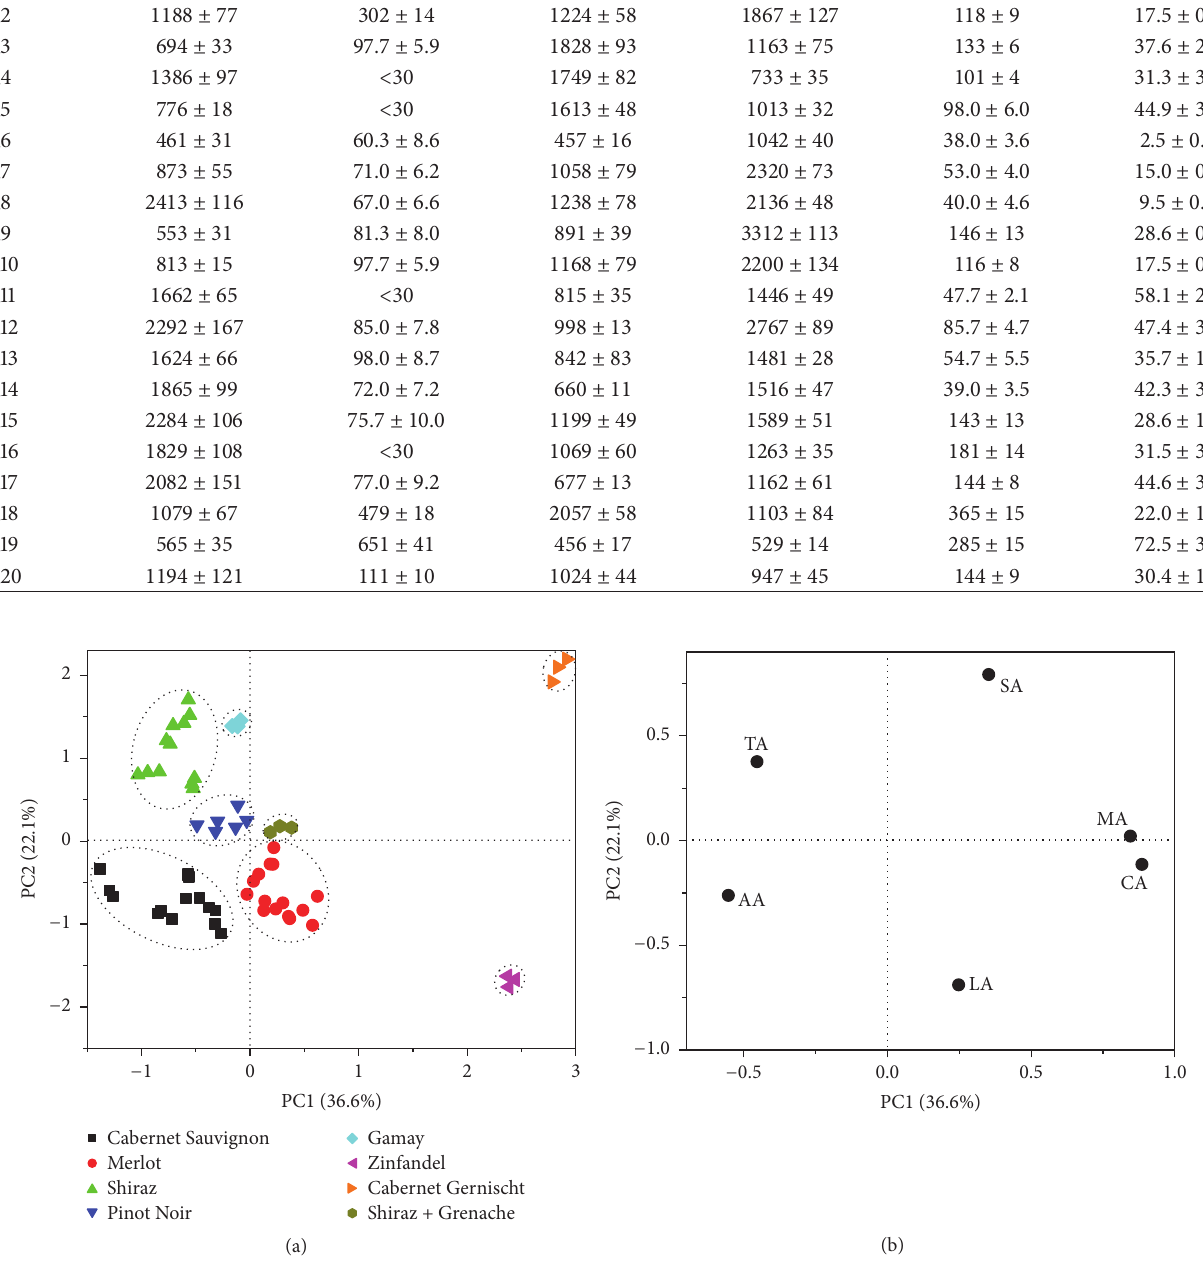
Figure 2: PCA score (a) and loading (b) plots for the discrimination of wine variety based on the organic acid profiles (20 samples × 6 variables × 3